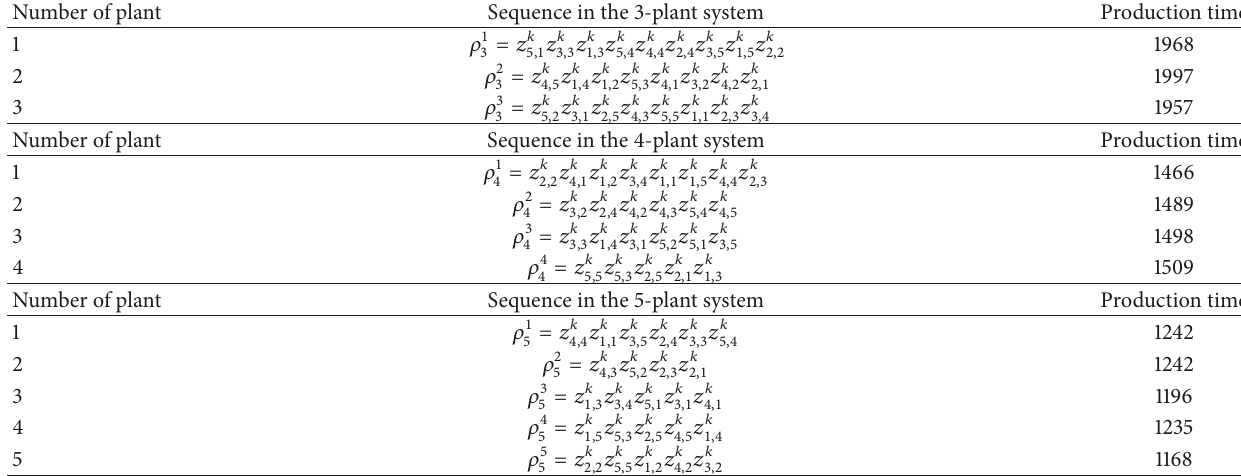
Table 4: Sequences leading to minimisation the total manufacturing time.